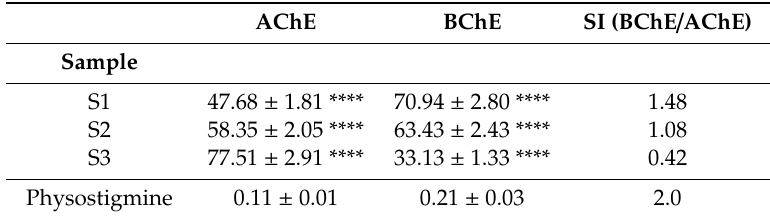
Table 2. In vitro anticholinesterase activity (IC 50 , µ g / mL) of S. o ffi cinalis essential oils. AChE BChE SI (BChE / AChE) Sample